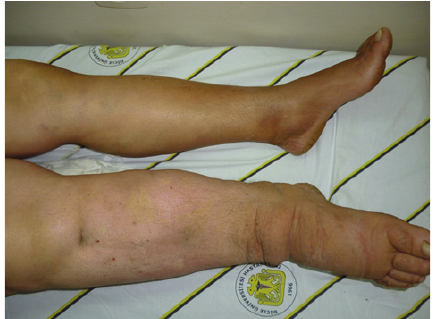
Figure 1: Scar tissue forming constrictions on the neck.